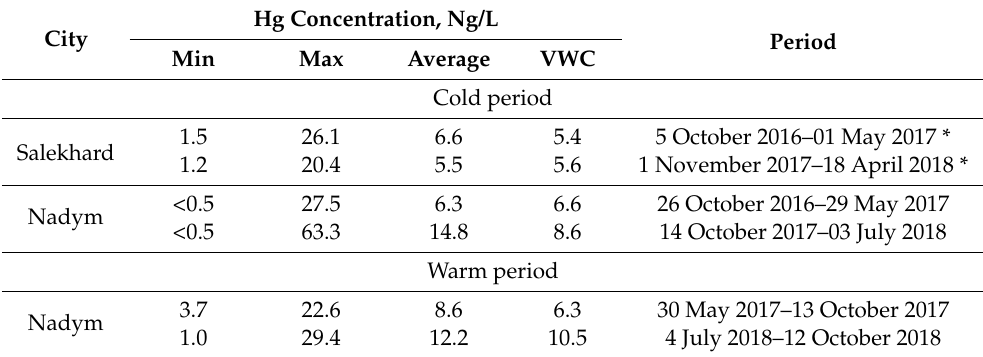
Table 2. Average values, ranges, and volume-weighted concentrations (VWC) of Hg in wet atmo- spheric precipitation of Salekhard and Nadym in different seasons and